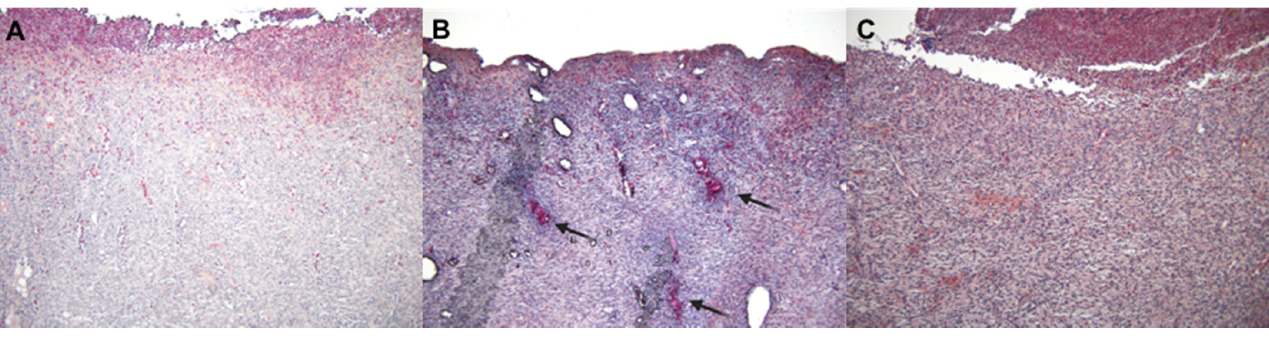
Figure 6. Histopathological changes in the wounds infected with MRSA. Naphthol AS-D chloroacetate-stained samples of porcine skin taken from the center of wounds, 100-fold the original magnification. ( A ) Non-infected samples with mild granulocyte infiltration underneath a fibrin clot. ( B ) Infected wound receiving no treatment with three microabscesses (indicated by arrows) and generally moderate granulocyte infiltration in the surrounding connective tissue. ( C ) Infected wound treated with beta-acid powder, showing mild granulocyte infiltration underneath a fibrin